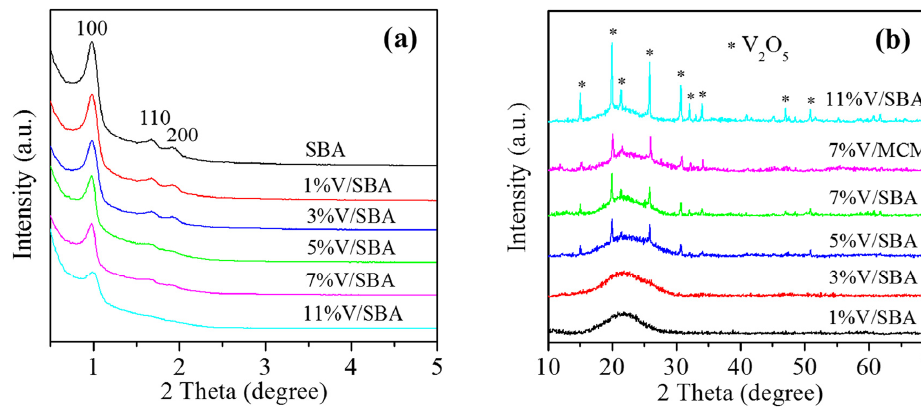
Figure 1. X ‐ ray diffraction (XRD) patterns of SBA ‐ 15 ‐ supported vanadia catalysts in the small ‐ angle Figure 1. X-ray diffraction (XRD) patterns of SBA-15-supported vanadia catalysts in the small-angle region ( a ) and in the wide ‐ angle region ( b ). region ( a ) and in the wide-angle region ( b